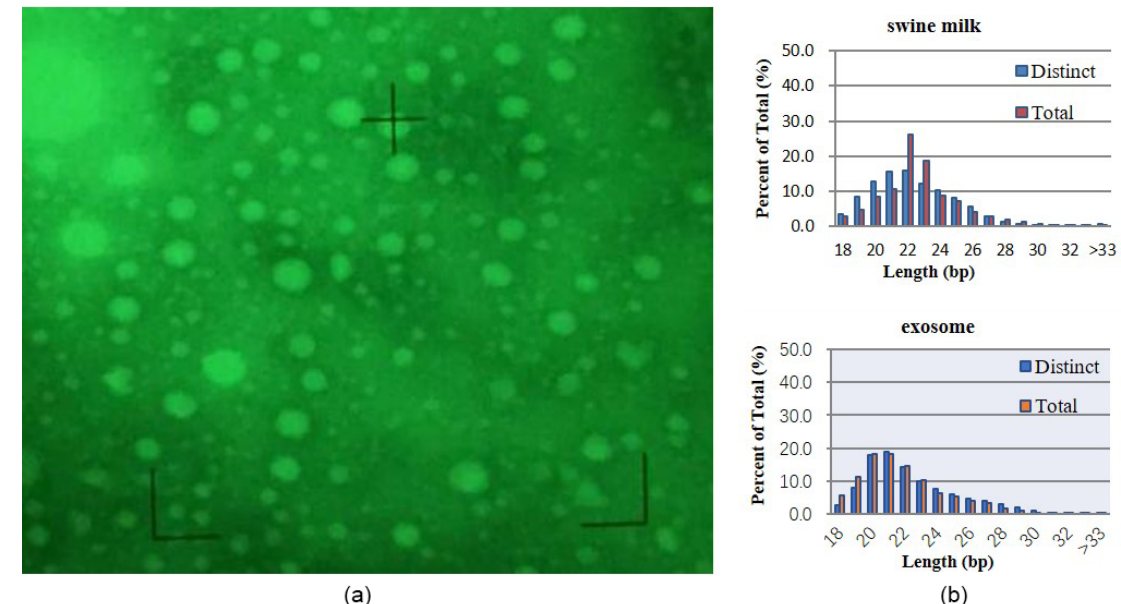
Figure 1. Basic analysis. (a) Exosomes isolated from swine milk. (b) Statistics of miRNA length from different